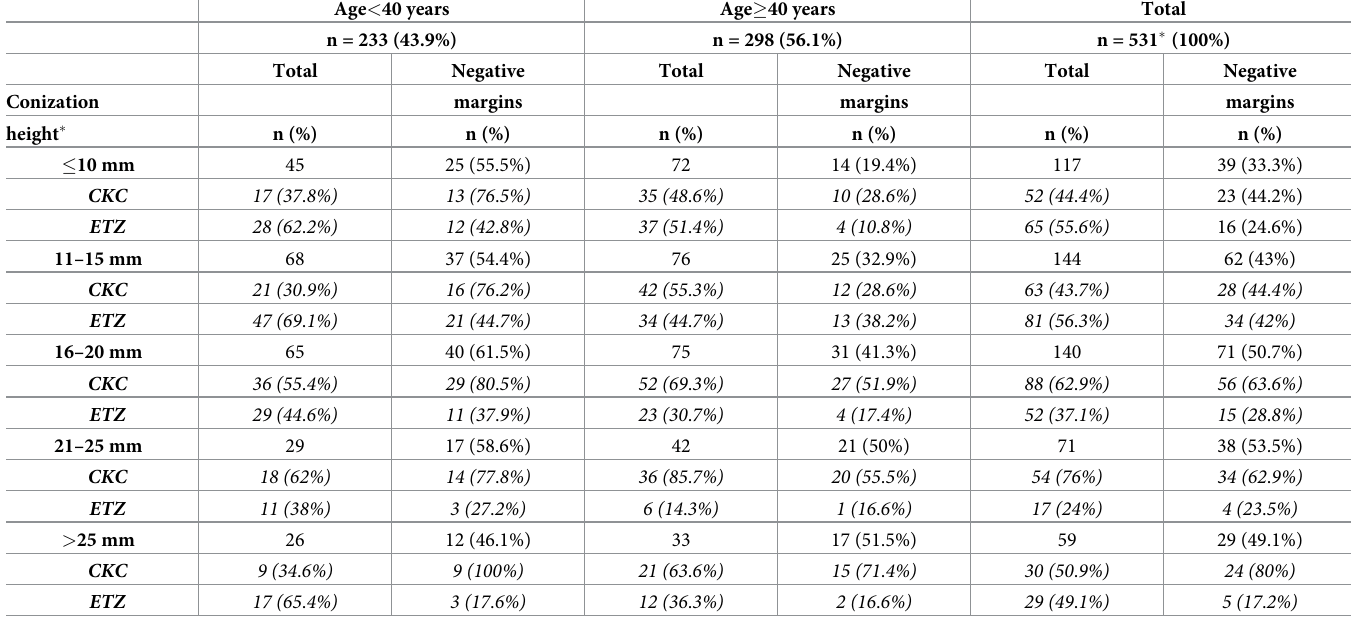
Table 3. The proportion of negative conization margins by age-group in the first cone procedure according to conization height and technique in 531 cases of microinvasive squamous cell carcinoma of the cervix stage